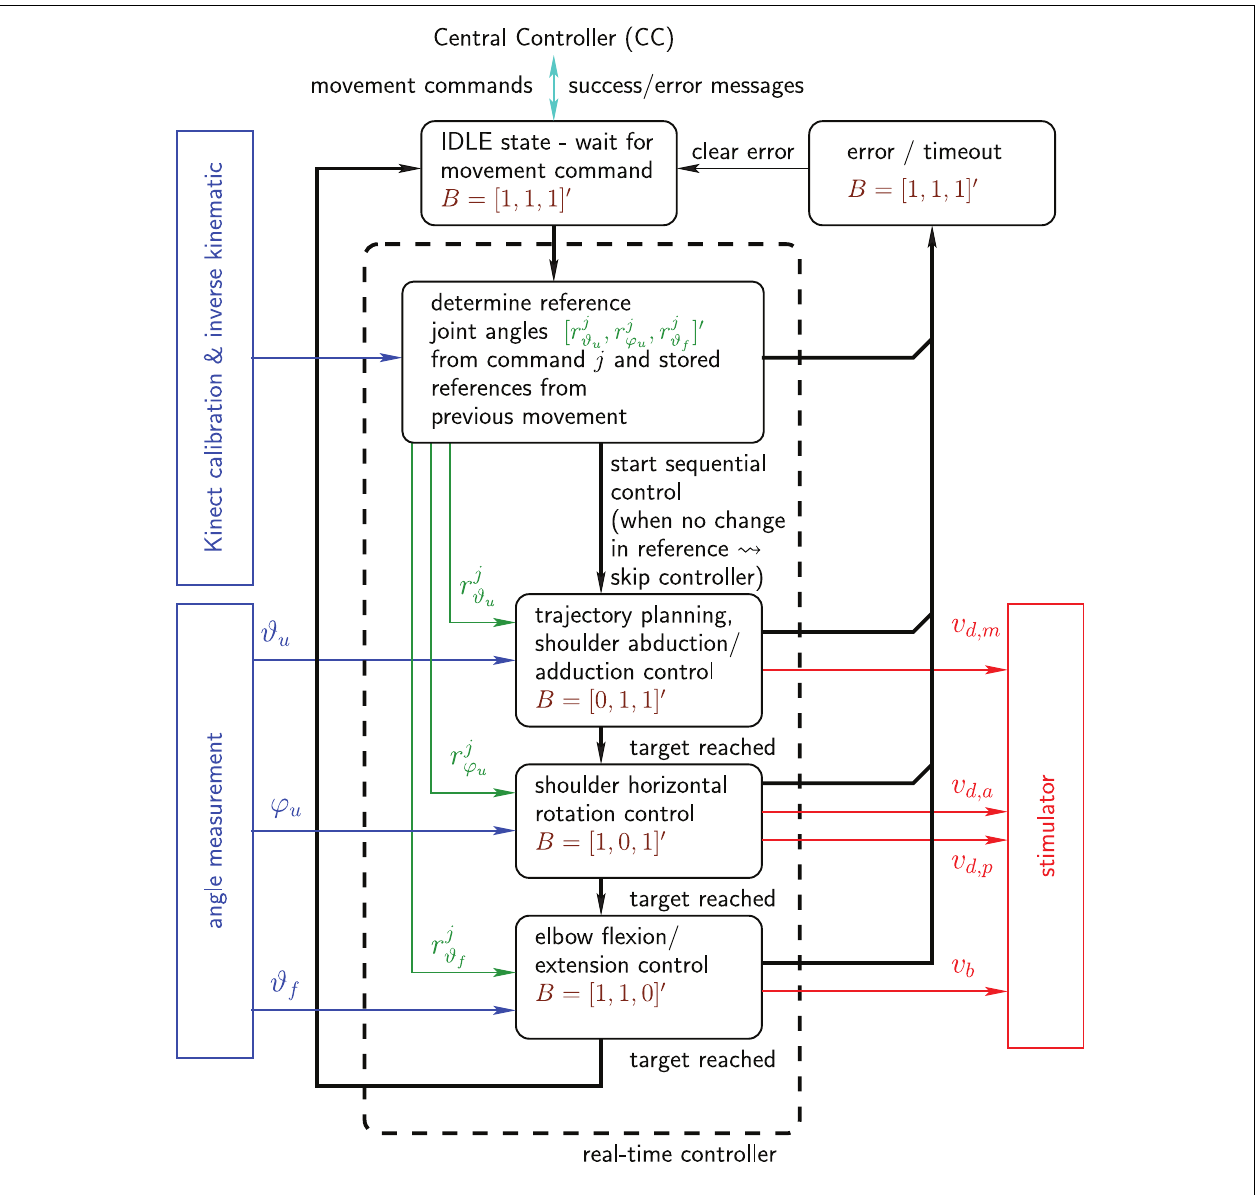
FIGURE 6 | Real-time arm NMES control system shown in form of a hybrid system combining a state automaton and continuous controllers: state transitions are indicated by black bold arrows, while continuous signals are represented by colored thin arrows.